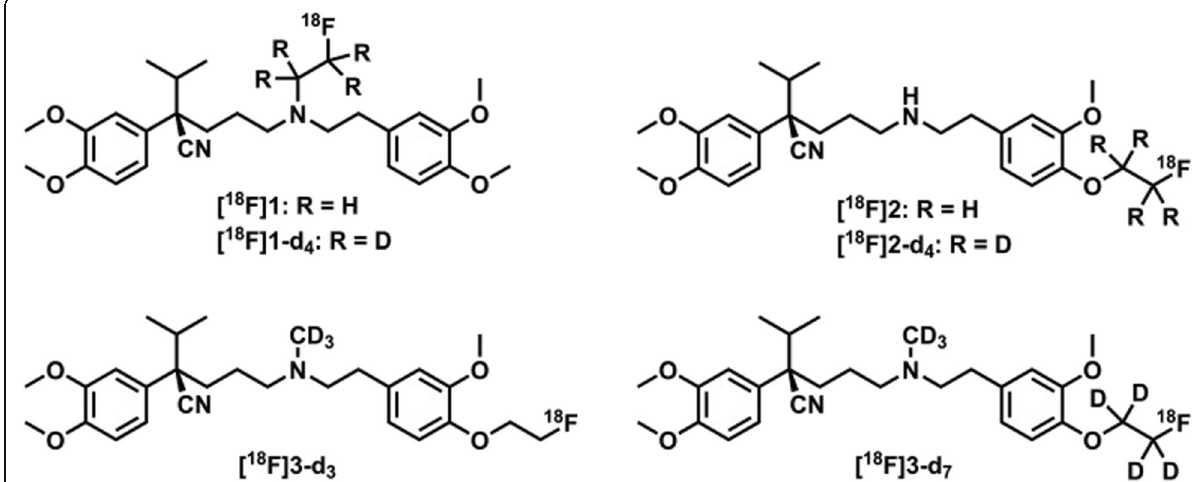
Fig. 12 Chemical structures of deuterated (nor-)verapamil analogs. Adapted with permission from Ref.